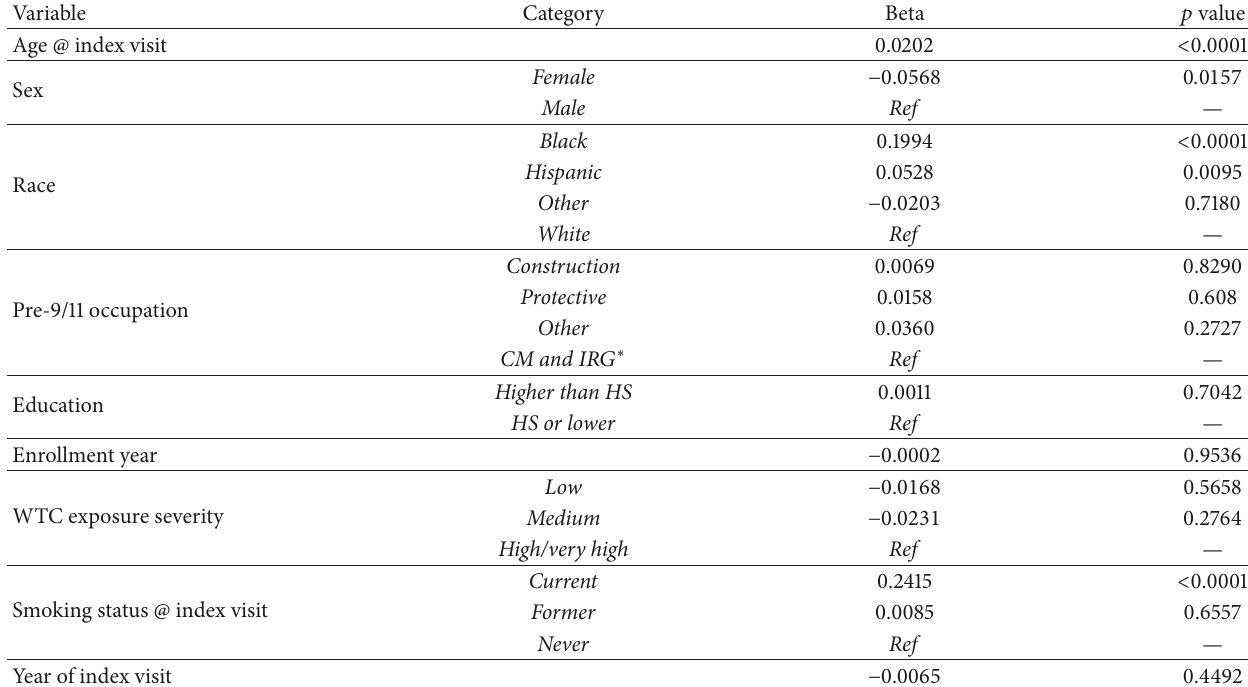
Table 5: Association between FI-Lab and various covariates: Columns 3 and 4 contain regression (beta) coefficients and corresponding 𝑝 values from negative binomial regression of FI-Lab (represented as deficit count) on various demographics